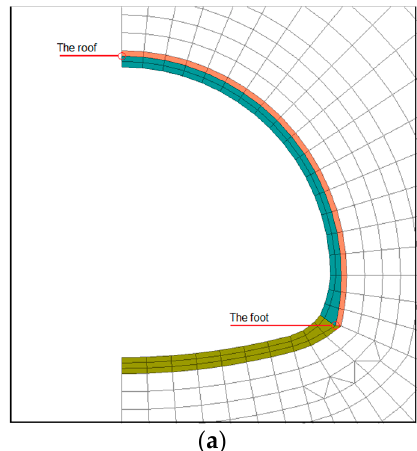
( d ) Figure 13. The minor principal stress of the roof. ( a ) Monitoring points plot; ( b ) the displacement of the roof; ( c ) the support stress of the bench; ( d ) the support stress of the invert. As a primary support of tunnel surface, concrete lining serves a number of functions, such as supporting adjacent ground and resisting ground erosion and degradation. The minor principal